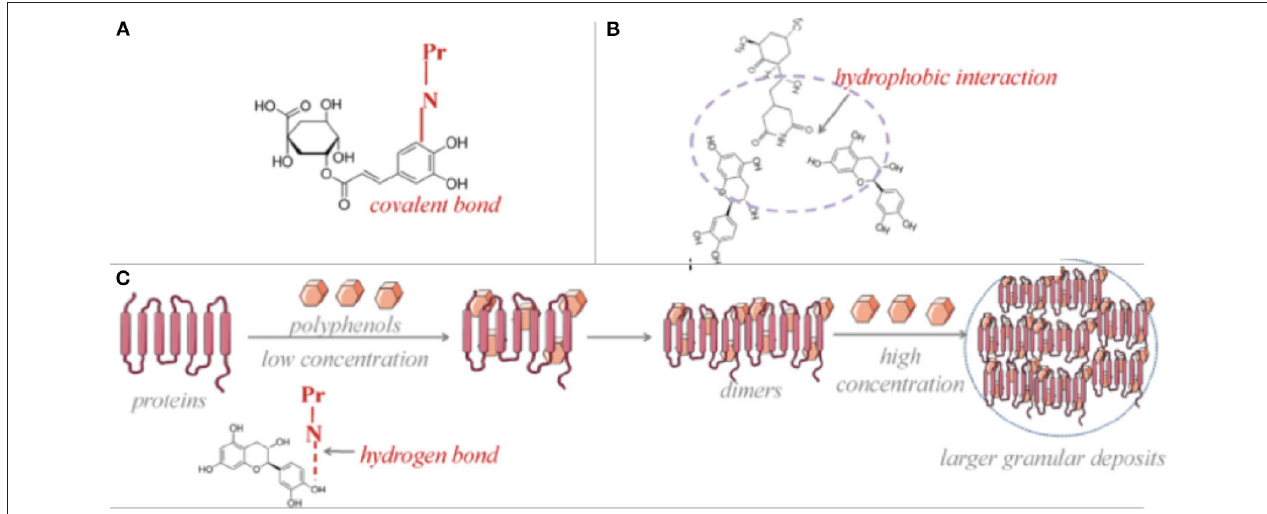
FIGURE 2 | Mechanisms of protein-phenolic compounds interactions as conjugation via covalent bond (A) , complexation via hydrophilic interactions (B) and hydrogen bonds (C) [Adapted from (113)].